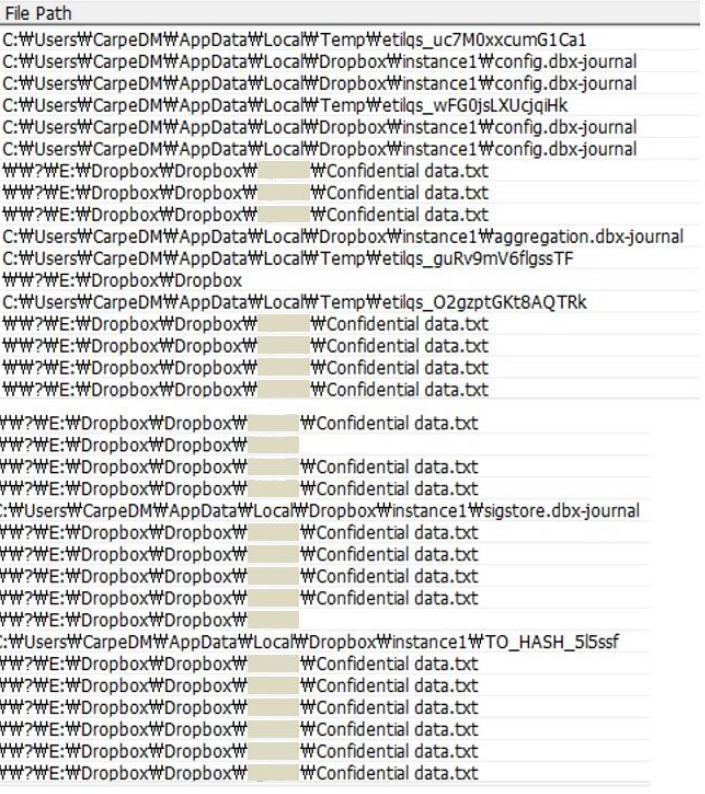
Figure 3. Synchronized file paths extracted from the detection module.